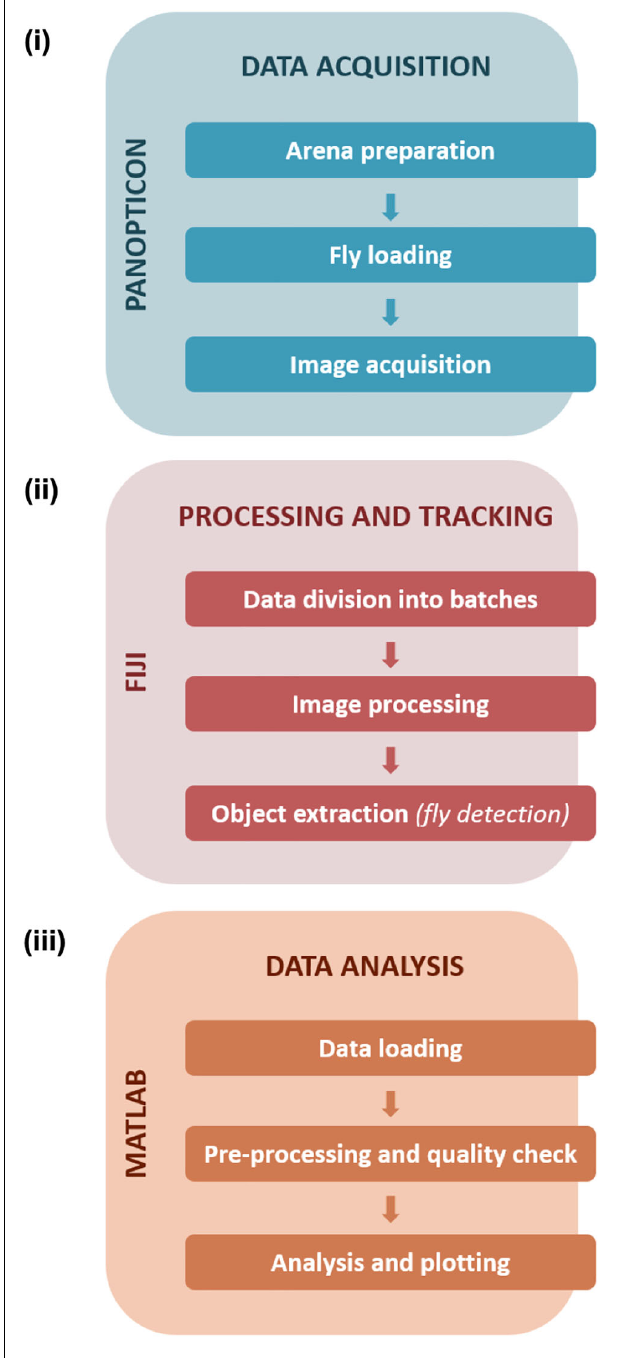
FIGURE 2 | Data handling and workflow. Data acquisition (i) steps with the Panopticon involve preparation of the arena with substrate media, collection and loading of single flies in each of the sectors, followed by recording of fly activity. Further processing and tracking (ii) of recorded data (in JPEG format) is performed on FIJI to further divide collected frames into batches to facilitate efficient image processing and subsequent detection of fly positions. Data analysis (iii) was executed in MATLAB and consisted of pre-processing and quality checks followed by in-depth analysis and plotting of the tracked data (saved and loaded as.csv